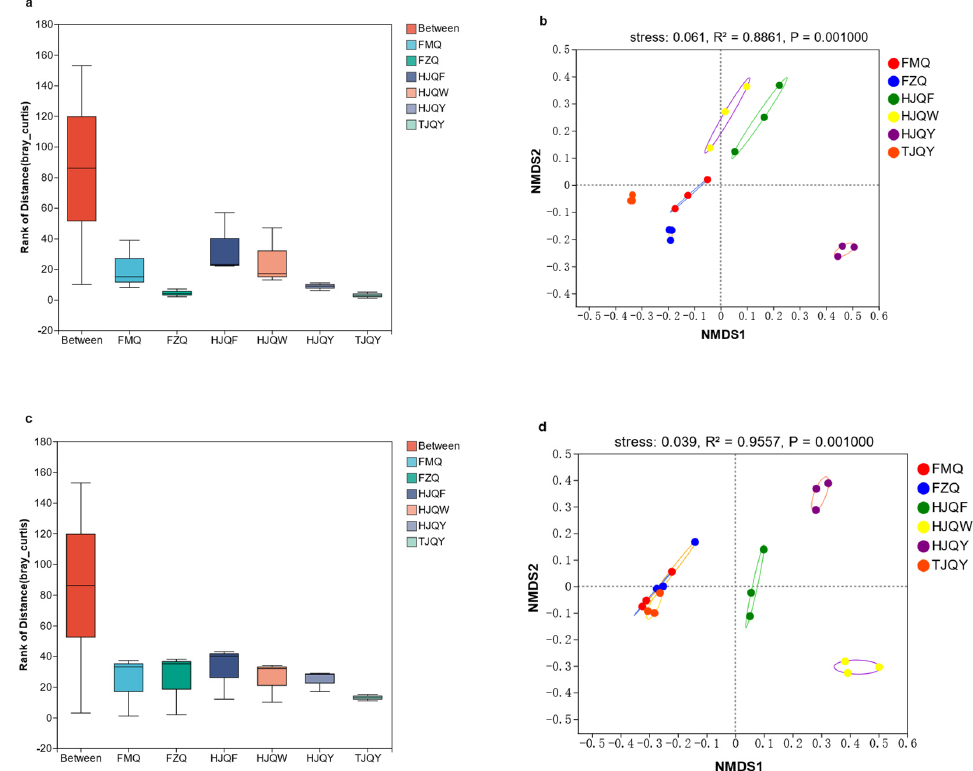
Figure 3. Comparison of the intergroup differences among microbial communities in JIUYAO; ( a ) box diagram of the similarity analysis between the bacterial groups based on Bray − Curtis distance algorithm; ( b ) NMDS analysis at the bacterial genus level; ( c ) box diagram of similarity analysis between the fungi groups based on Bray − Curtis distance algorithm; ( d ) NMDS analysis at the fungi genus level.